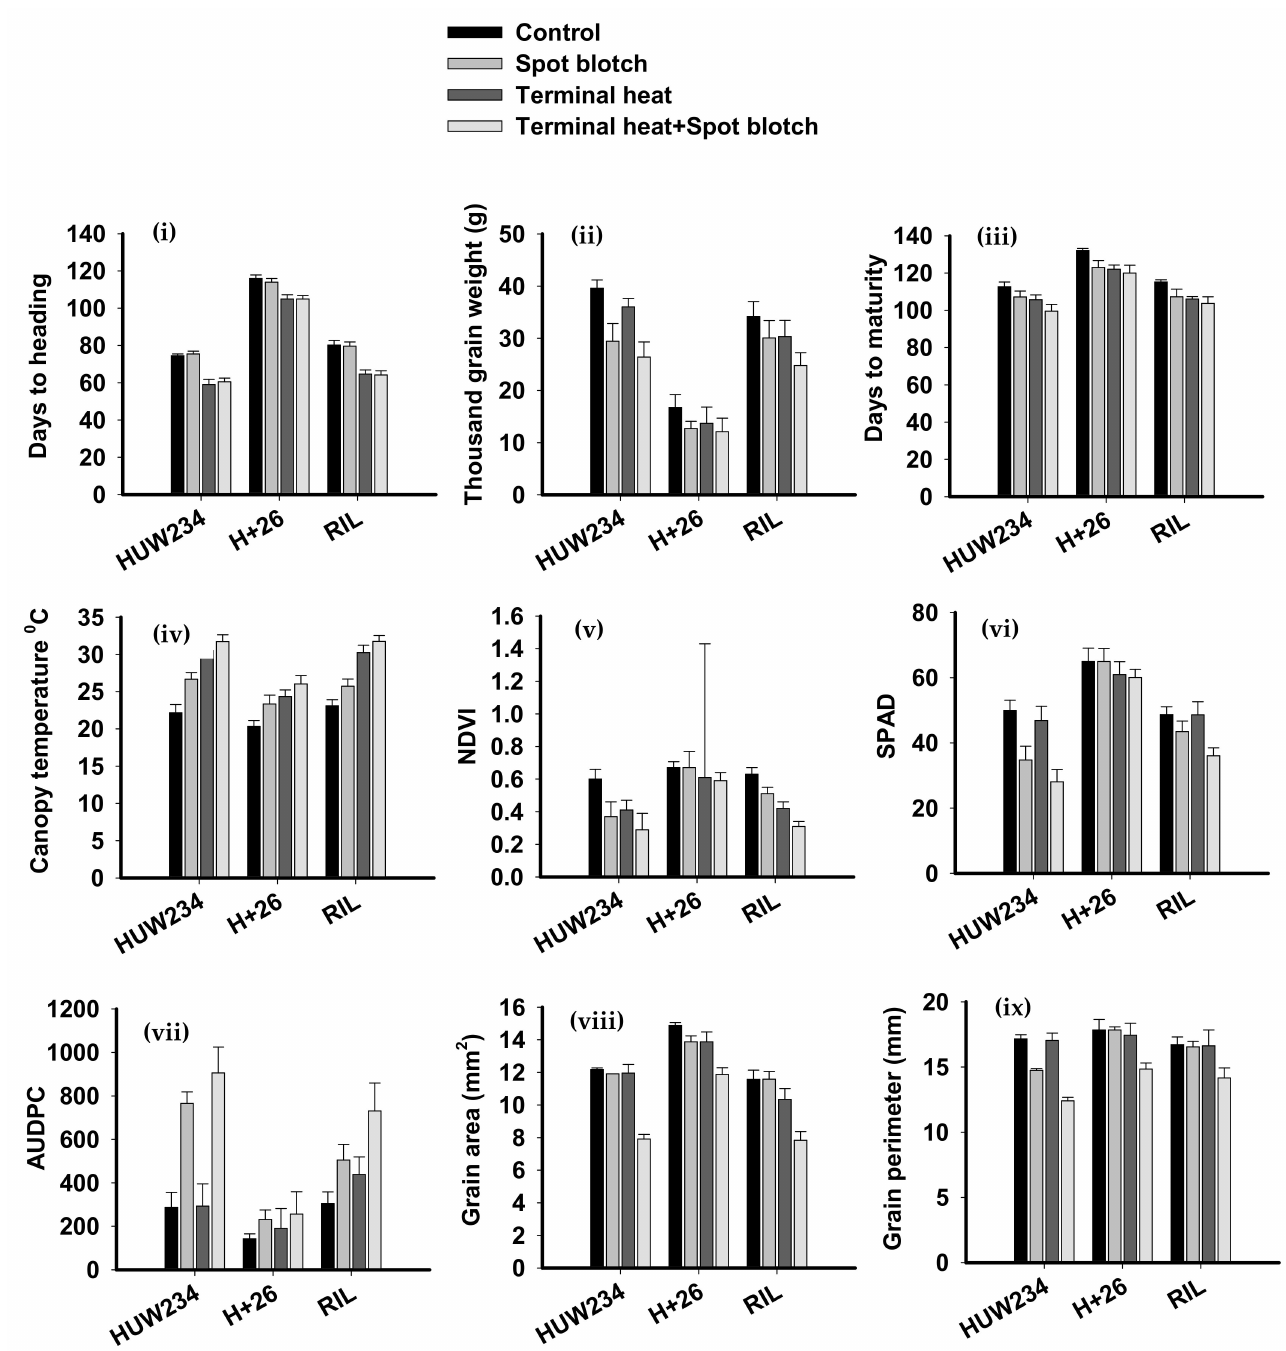
Figure 1. Summary of the effect of biotic and abiotic stresses on nine quantitative traits: ( i ) days to heading, ( ii ) thousand kernel weight, ( iii ) days to maturity, ( iv ) canopy temperature, ( v ) normalized distributed vegetation index (NDVI), ( vi ) soil plant analysis development (SPAD), ( vii ) area under disease progress curve (AUDPC), ( viii ) grain area, and ( ix ) grain